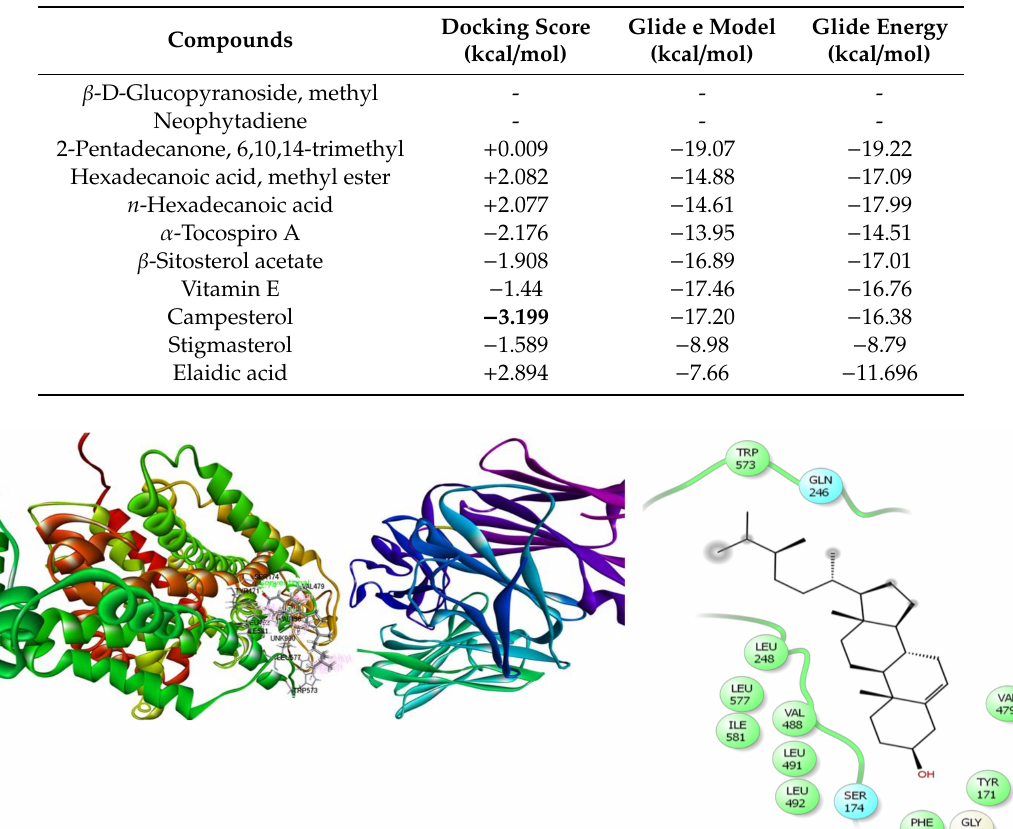
Table 4. Docking score of the identified compounds with human serotonin receptor (pdb: 5I6X) for antidepressant activity. Bold indicate the highest docking score.